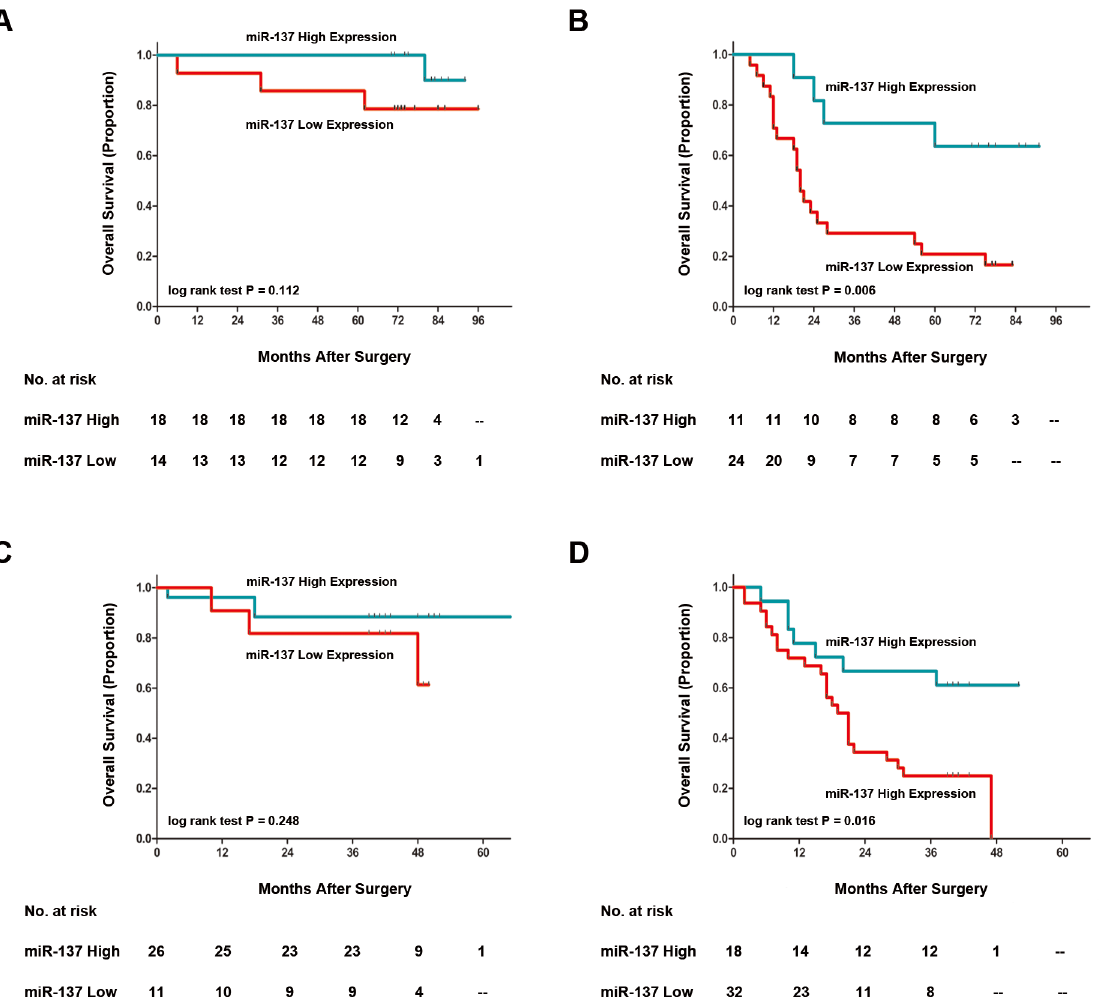
Fig 3. Stratified analysis of overall survival according to the expression of miR-137 in gastric cancer patients with different TNM stage. Kaplan- Meier analyses of overall survival according to miR-137 expression in (A) Training set, TNM stage I+II (n = 32), (B) Training set, TNM stage III (n = 35), (C) Validation set, TNM stage I+II (n = 37), and (D) Validation set, TNM stage III (n = 50). P value was calculated by log-rank